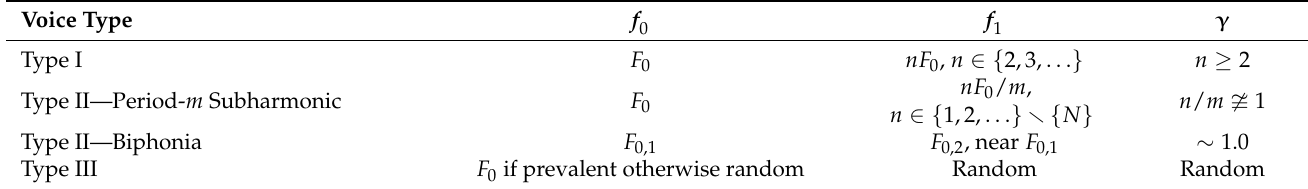
Table 1. Expectation of Frequency Estimates 1